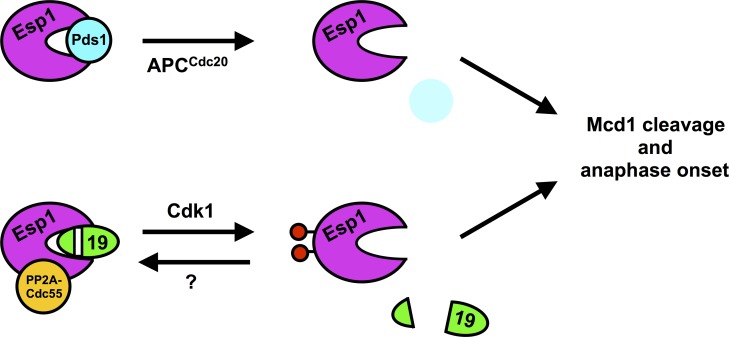
Proposed model for redundant inhibition of Esp1 by Pds1 and Slk19.Our data support a model in which both Pds1 and Slk19 (19) inhibit Esp1. Anaphase onset is triggered by both APCCdc20-mediated proteolysis of Pds1 and Cdk1-dependent activation of Esp1. Slk19 and PP2ACdc55 inhibit Esp1, and Cdk1 phosphorylation of Esp1 overcomes this inhibition. We speculate that Esp1 phosphorylation triggers the release of Slk19 from the active site of Esp1. Although PP2ACdc55 can dephosphorylate Esp1 in vitro and cdc55Δ cells increase Esp1 phosphorylation in vivo, the lack of suppression of cdc55Δ by esp1-3A suggest that PP2ACdc55 binding to Separase may be more important for Esp1 inhibition. Slk19 can inhibit Separase either as an uncleaved or cleaved (as depicted) protein.